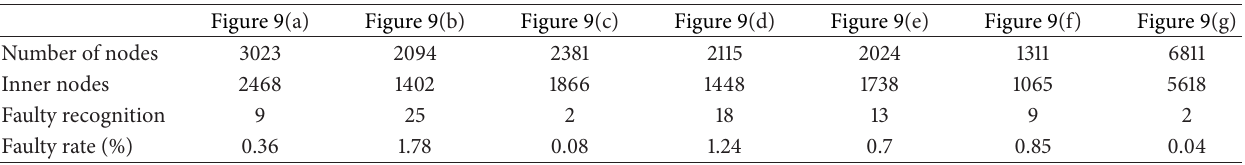
Table 1: Statistics of faulty